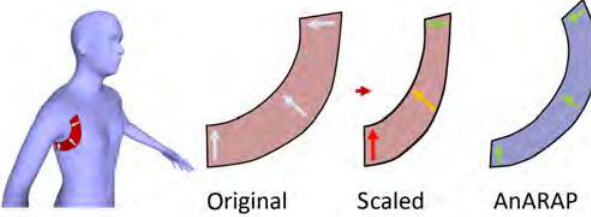
Fig. 11 The desired compression directions are defined for a patch (left). The original method of scaling fails to distribute the compression well (middle). Our method maintains the desired compression over the whole surface.